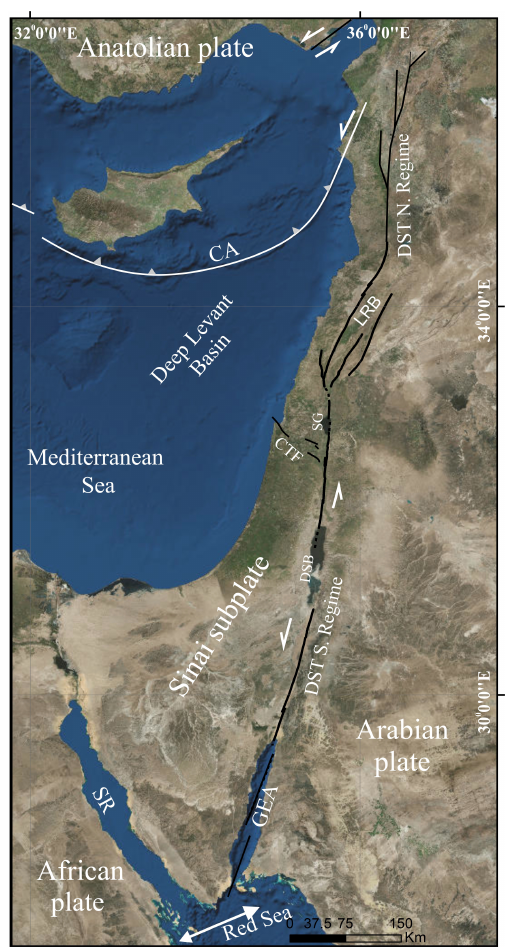
Figure 1. Plate configuration in the eastern Mediterranean. Arrows show relative motion. SR – Suez rift; GEA – Gulf of Elat (Aqaba); DST – Dead Sea Transform fault system; CTF – Carmel-Tirza fault zone; LRB – Lebanon restraining bend; CA – Cyprian Arc; DSB